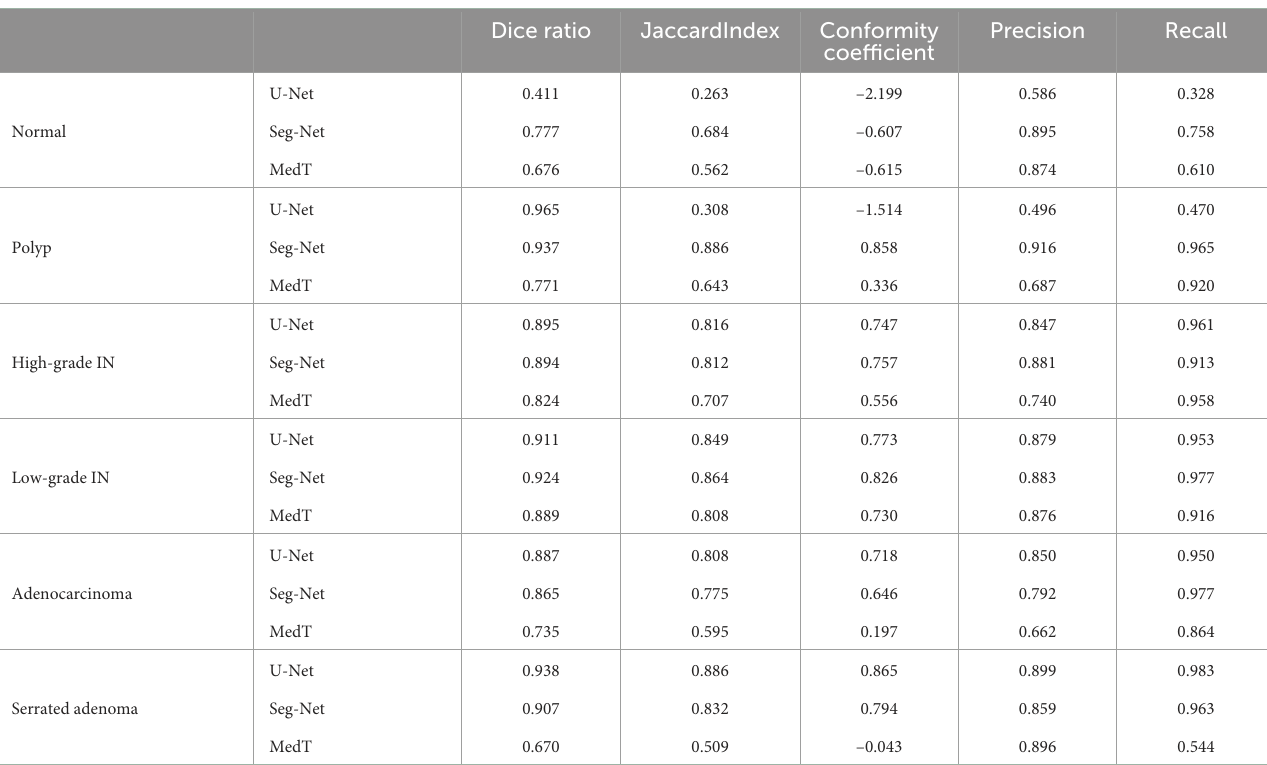
TABLE 5 Evaluation metrics for three different segmentation methods based on deep